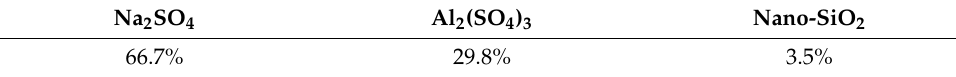
Table 1. Raw materials of molten salt (wt%).